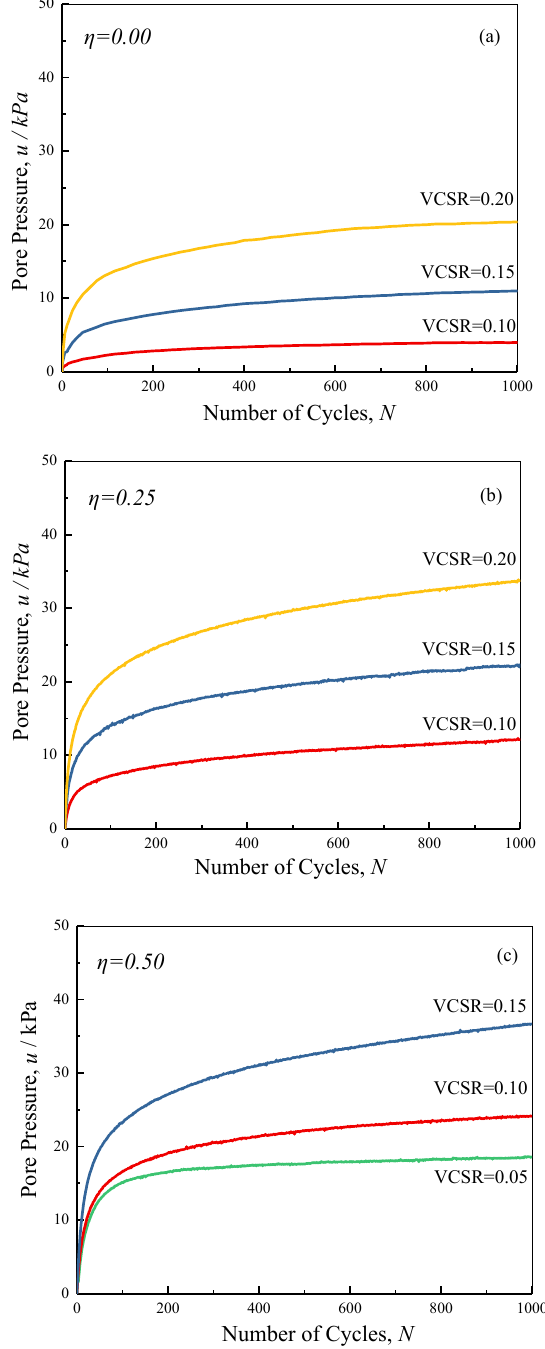
Figure 5. Pore pressure versus number of cycles under different cyclic loading: ( a ) η = 0.00; ( b ) η = 0.25; ( c ) η = 0.50.